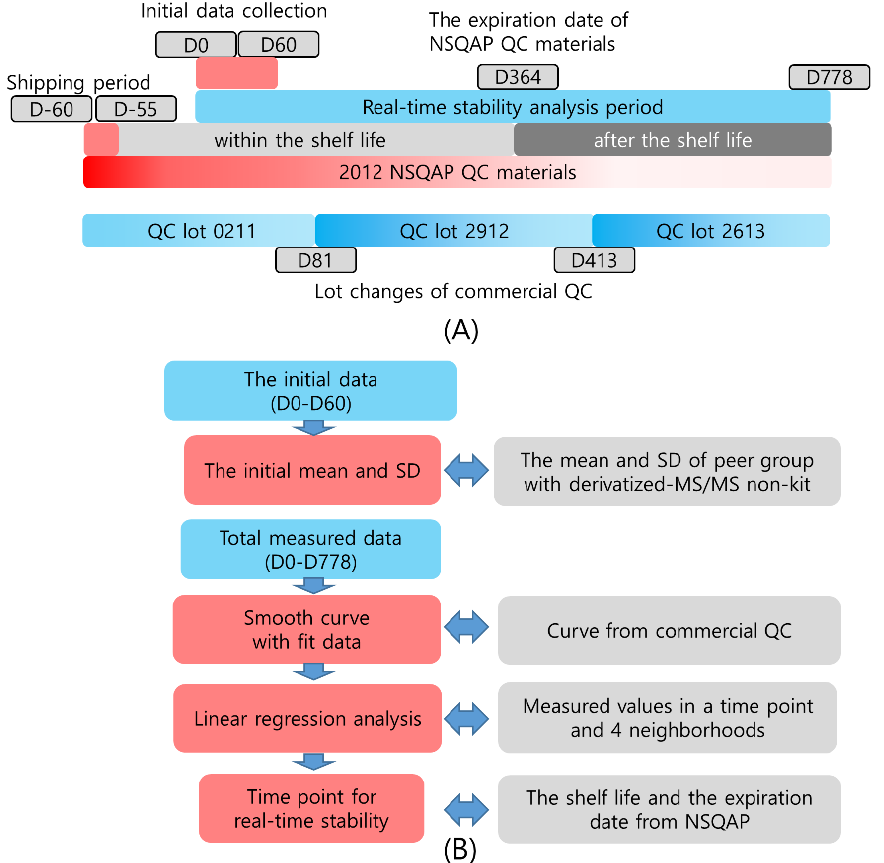
Figure 1. Time course of NSQAP QC marterials and study design of real-time stability test. Between D0 (3 September 2012) and D788 (31 October 2014), schematic time course of NSQAP QC marterials ( A ), and study design of real-time stability ( B ) in current study were illustrated.